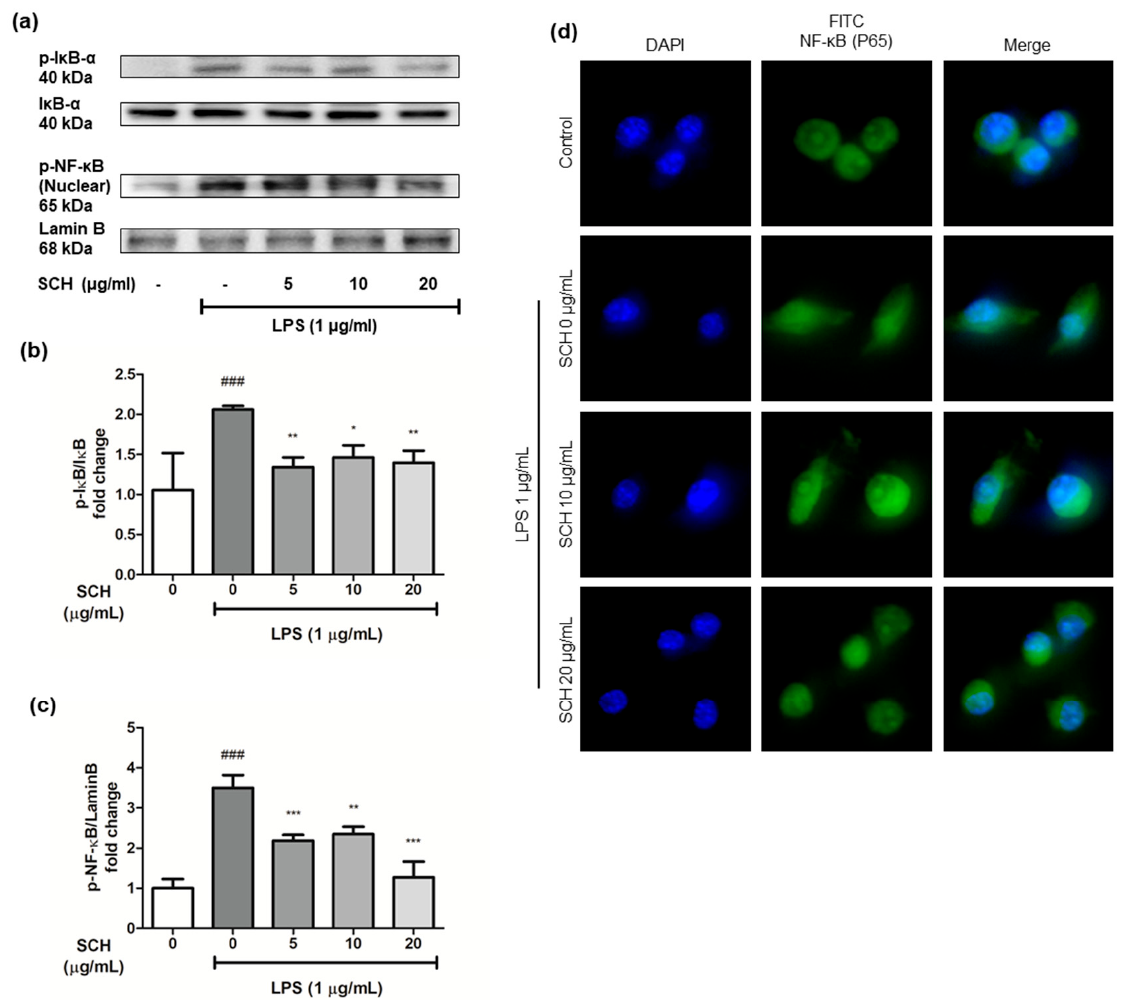
Figure 7. Effect of SCH on NF- κ B activity as demonstrated by western blot and immunofluorescence analysis in LPS- induced Raw 264.7 cells. ( a ) Representative immunoblot images of NF- κ B and I κ B- α and their phosphorylated forms in cytosol. ( b , c ) The band intensities of immunoblots of phosphorylated NF- κ B and I κ B- α were measured and normalized versus intensities in non-treated cells. ( d ) Immunofluorescence images showing the effect of SCH treatment on the nuclear localization of NF- κ B. Results are presented as means ± SDs. # p < 0.05, ## p < 0.01 vs. non-treated controls and * p < 0.05, ** p < 0.01 vs. LPS-induced cells.